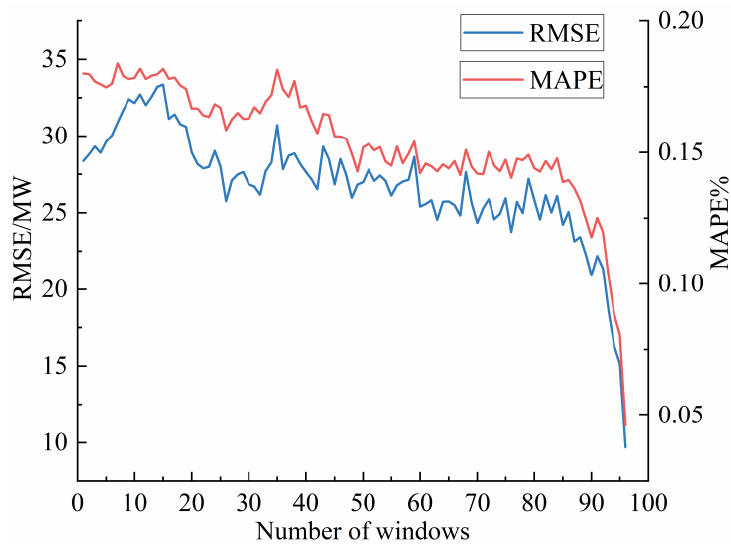
Figure 9. The corresponding error of window size.